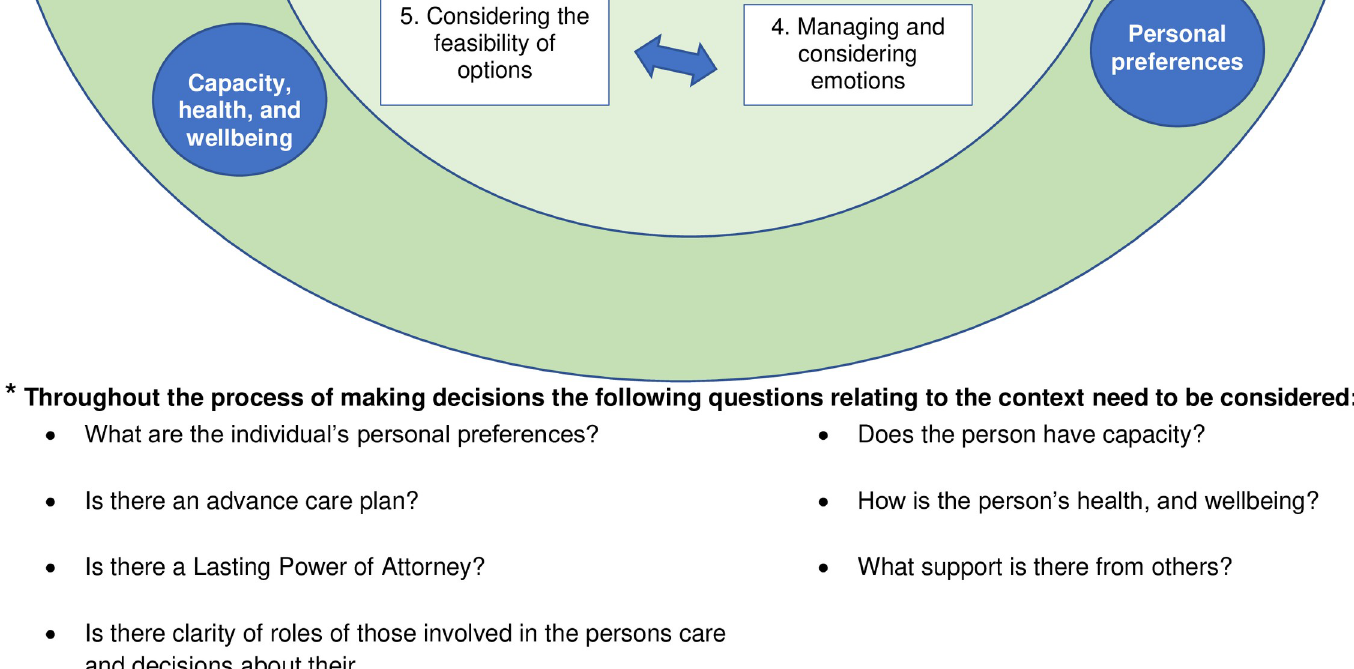
PLOS ONE | https://doi.org/10.1371/journal.pone.0252464 May 27,